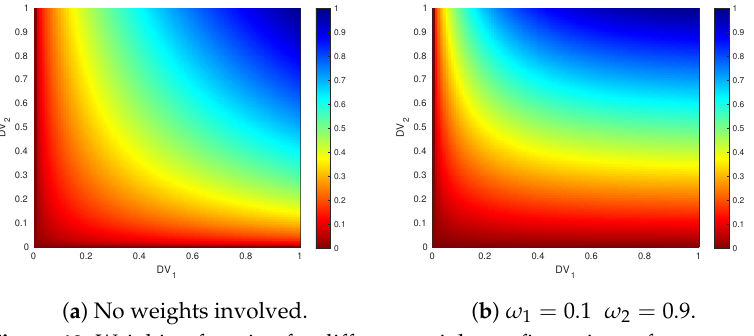
( b ) ω 1 = 0.1 ω 2 = 0.9. Figure 10. Weighing function for different weight configurations of two